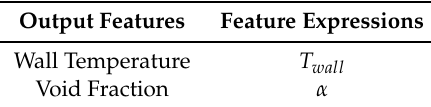
Table 3. Output features (quantities of